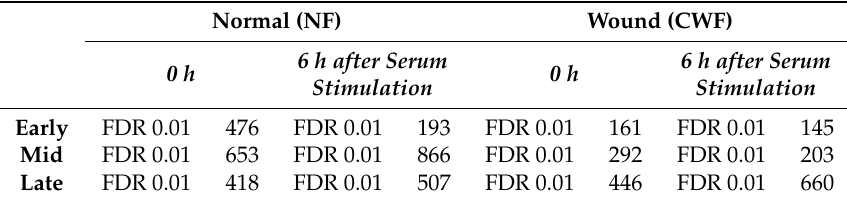
Table 3. Counts of genes identified as significantly different (FDR 0.01).